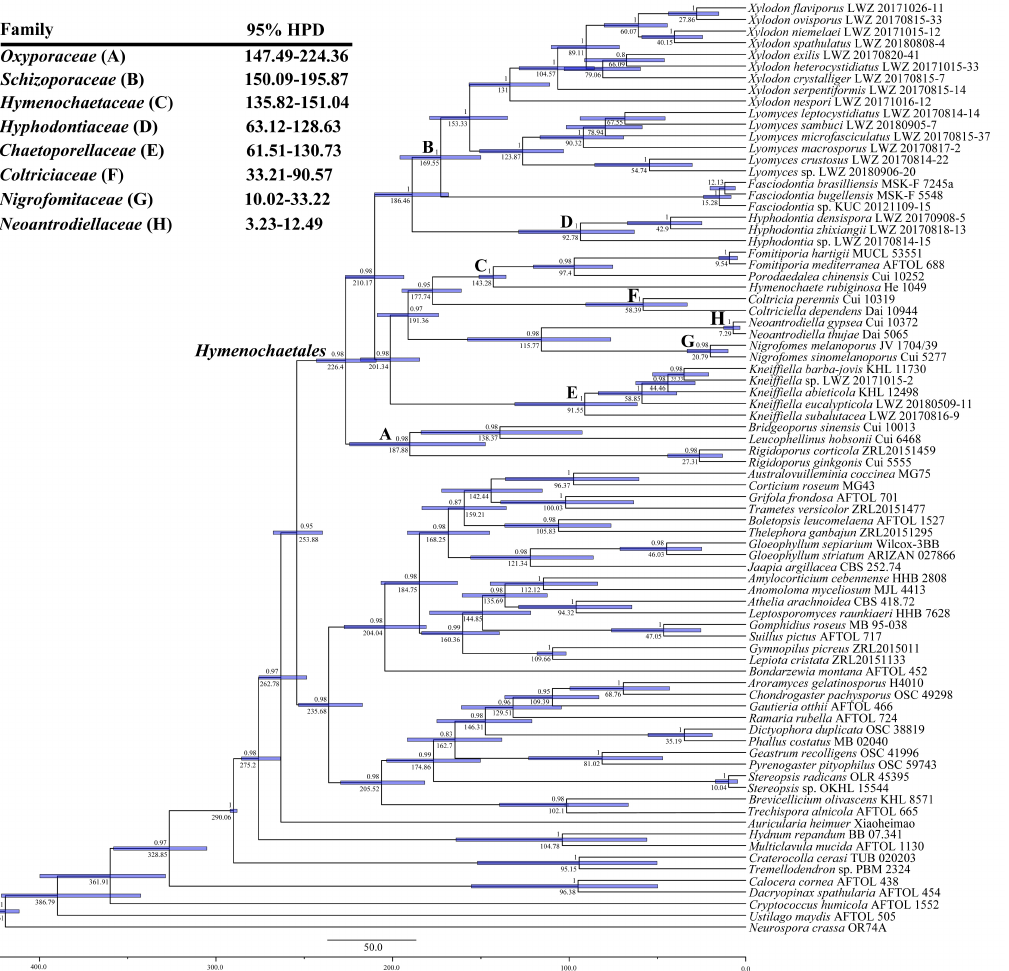
Figure 6. Maximum-clade-credibility chronogram and estimated divergence times of families within Hymenochaetales inferred from the combined dataset of ITS, nLSU, tef1 α , rpb1 and rpb2 regions. The estimated divergence times of 95% highest posterior density for all clades were indicated as node bars and for families in Hymenochaetales were also provided in the upper-left of the tree as exact numbers, while the Bayesian posterior probabilities above 0.8 and the mean divergence times of clades were labeled above and below the branches, respectively, at the